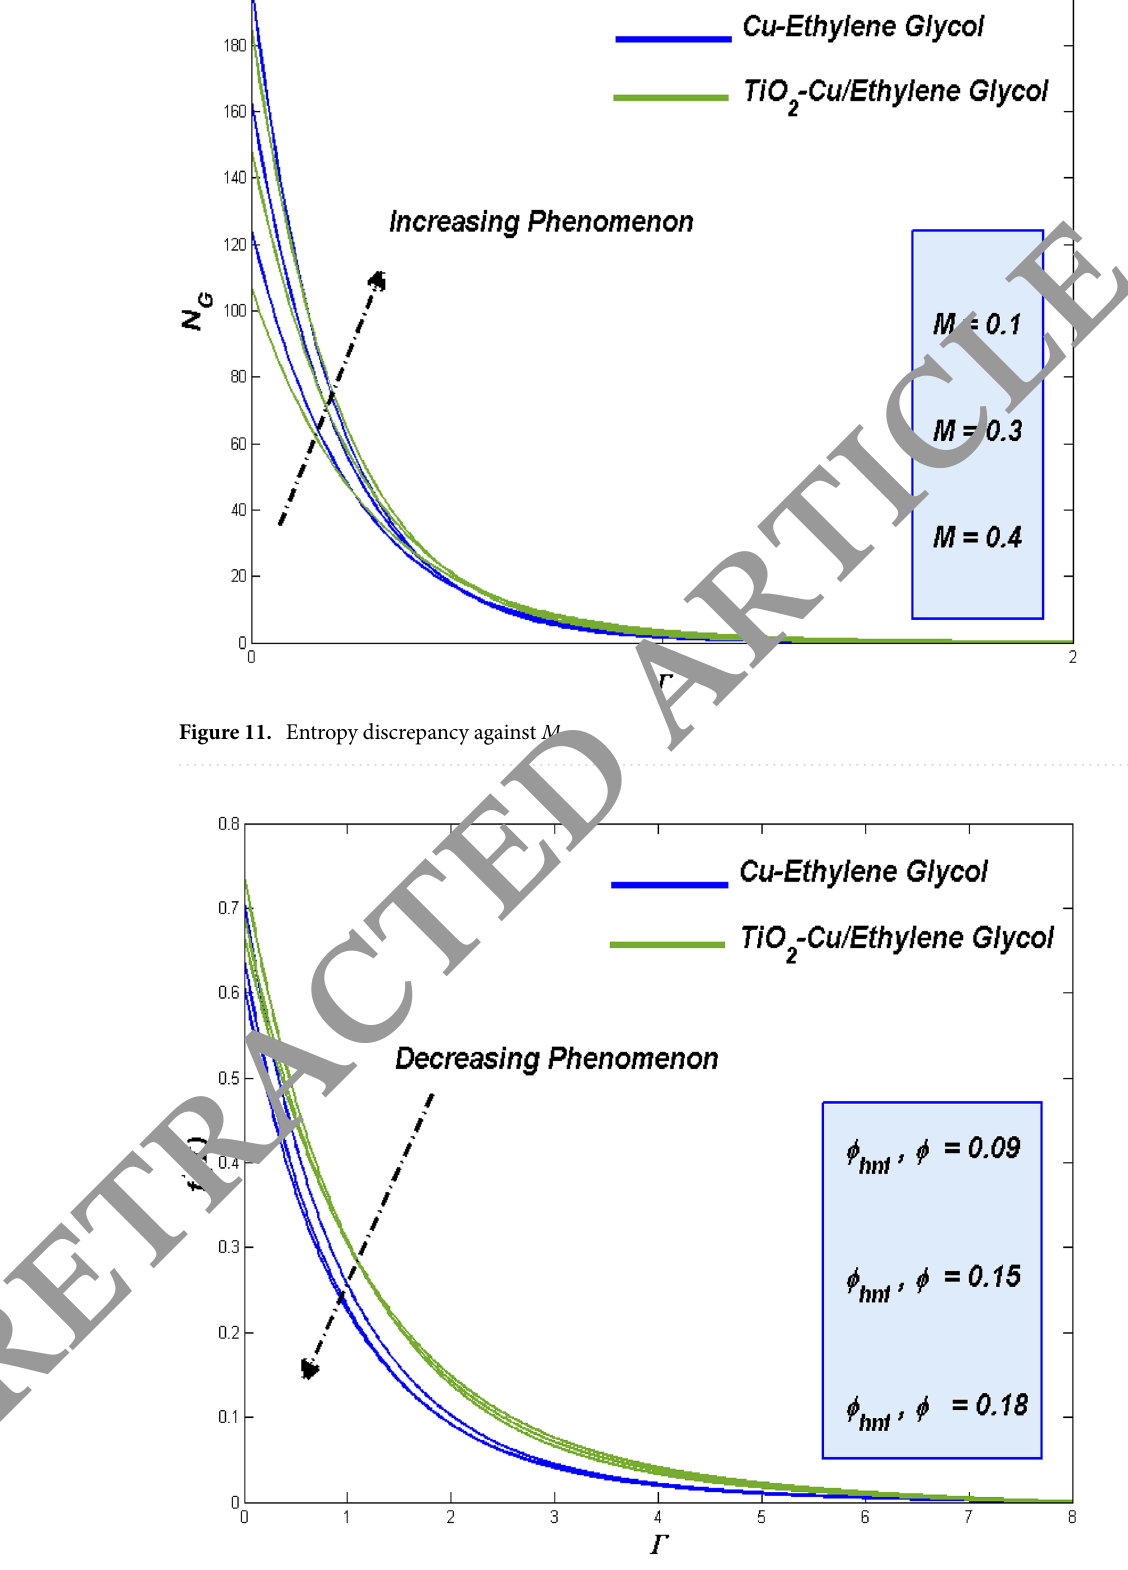
Figure 12. Velocity discrepancy against φ and φ hnf